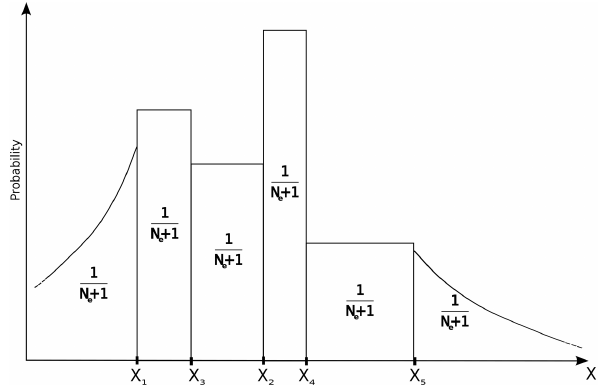
Figure 3. Reconstruction of a density from an ensemble using the rank histogram